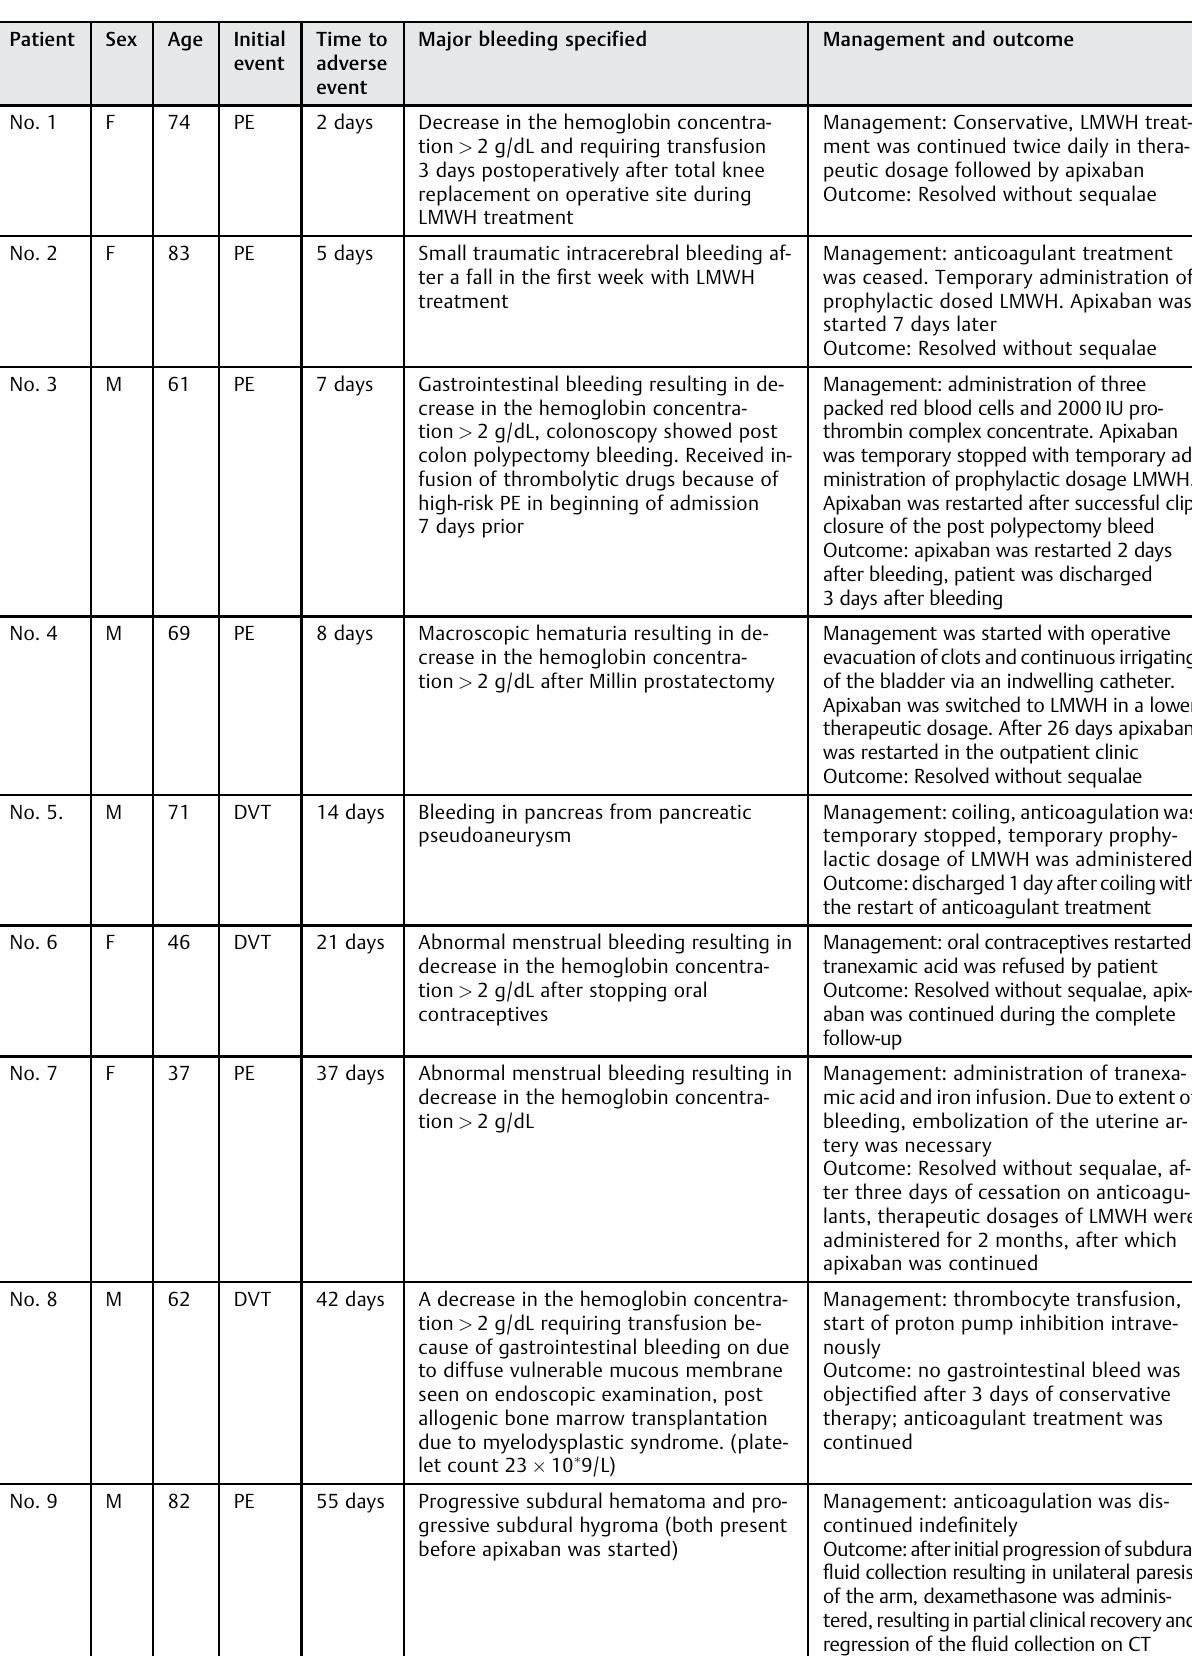
Table 3 Detailed information of major